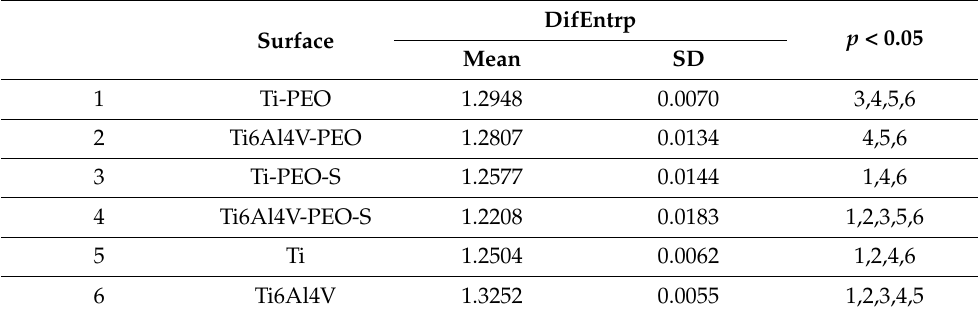
Table 6. Post hoc ANOVA results (least significant difference) for comparison of difference entropy (DifEntrp) for ROI size 100 µ m × µ m between each examined surface (SD—standard deviation).